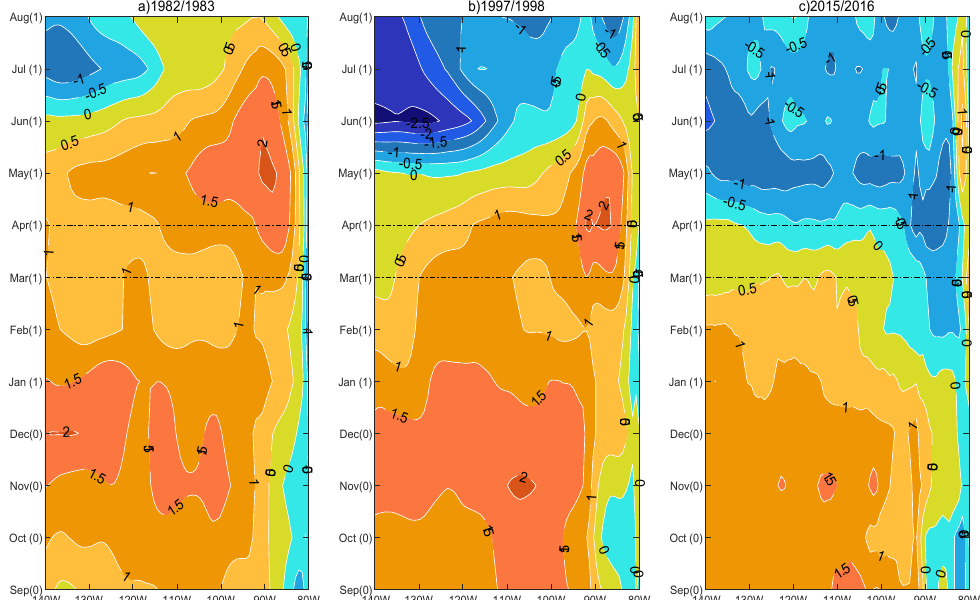
Figure 7. Time evolution of the delta SST over the eastern Pacific during the three strongest El Niño years: ( a ) 1982/1983, ( b ) 1997/1998, ( c ) 2015/2016. The delta SST represents SSTA EQ − 0.5*(SSTA SH + SSTA NH ). Here EQ (or NH, or SH) denotes the latitudes within (1.5° S–1.5° N) (or (3.75° N–6.75° N), or (3° S–6° S)). The numbers in parentheses following the months are 0 for the developing year and 1 for the decaying year of El Niño.